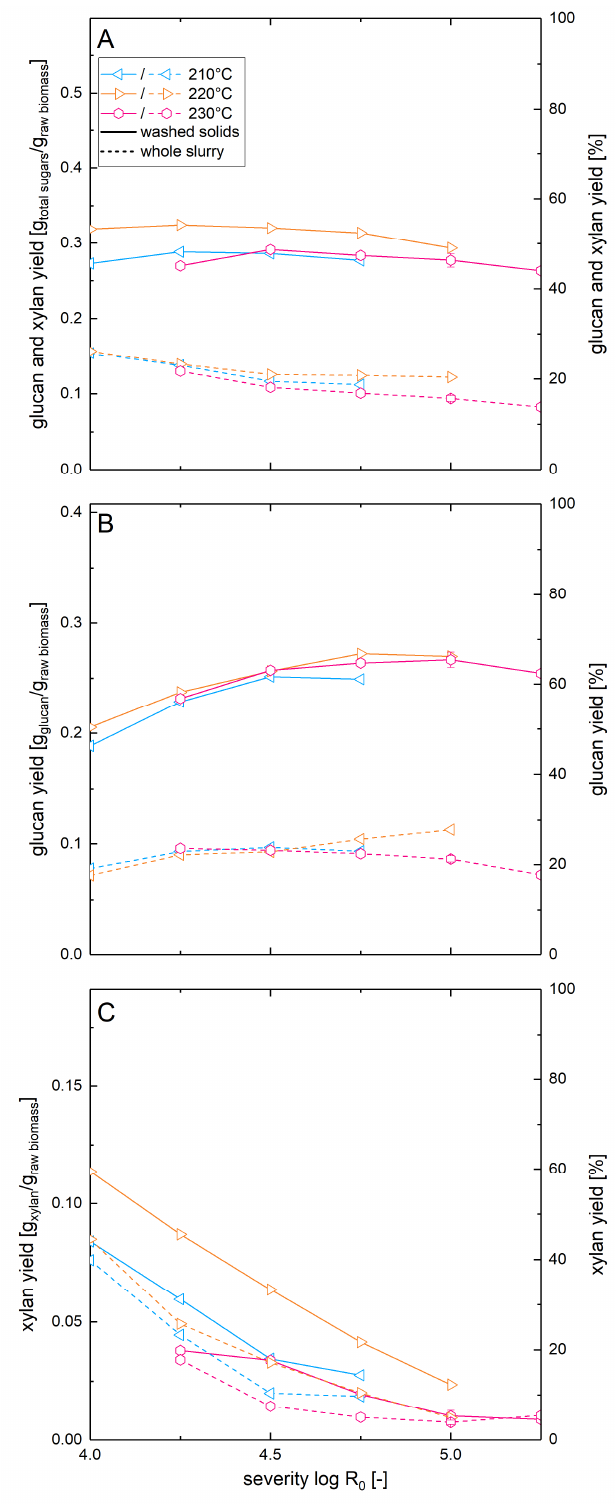
Figure 5. Solubilization and recovery of glucan and xylan after pretreatment and high solid enzymatic hydrolysis. Shown are the recoveries of ( A ) total sugars, ( B ) glucan and ( C ) xylan as soluble molecules after steam explosion pretreatment and whole slurry enzymatic hydrolysis (dashed line) or combined enzymatic hydrolysis of washed solids and acid hydrolysis of the prehydrolyzate (solid line). A glucan loading of 5% was